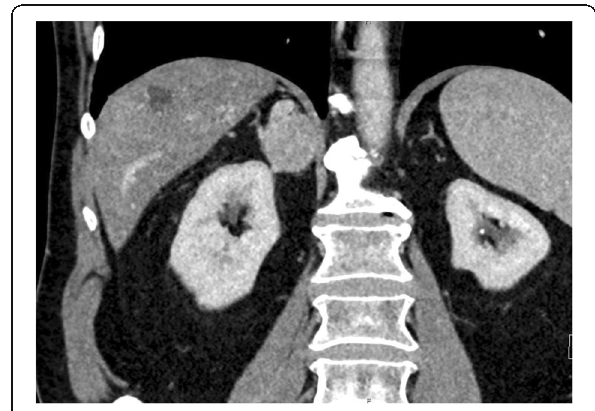
Fig. 1 Delayed contrast-enhanced abdominal computed tomography scan of the solid lesion in the right adrenal gland. The lesion is measuring 4.5 × 3.4